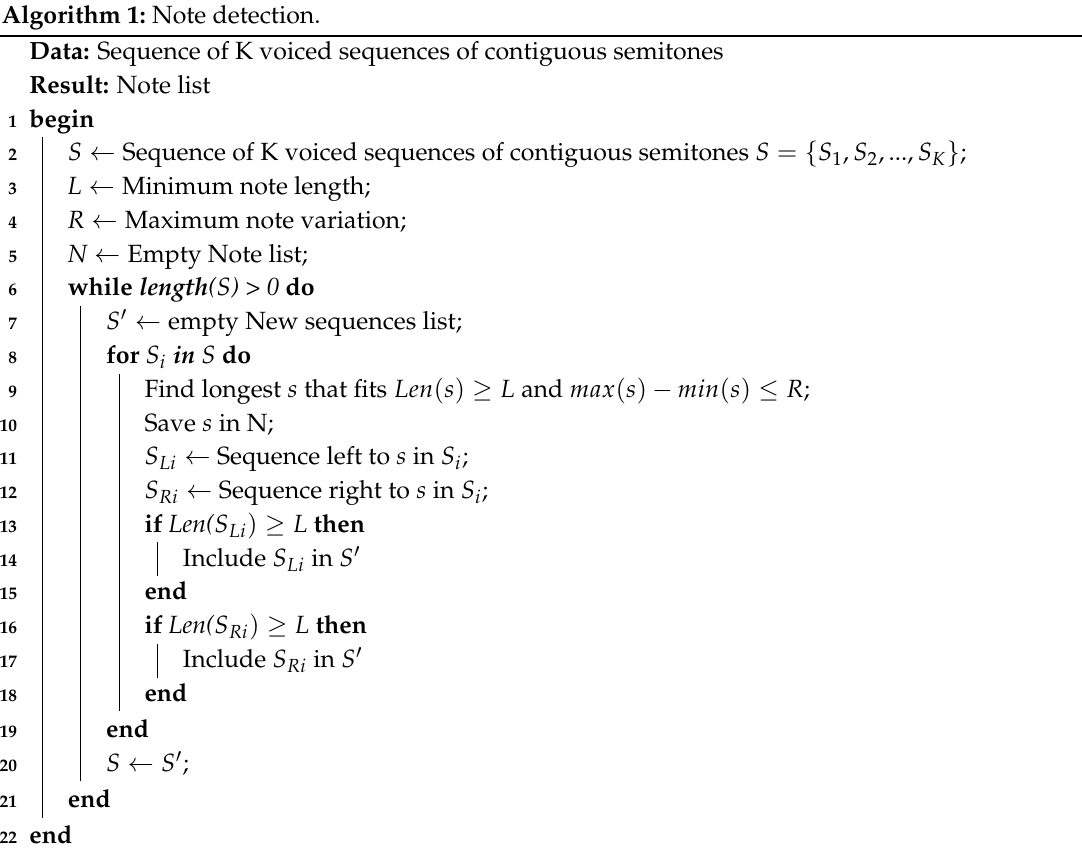
Algorithm 1: Note detection. Data: Sequence of K voiced sequences of contiguous